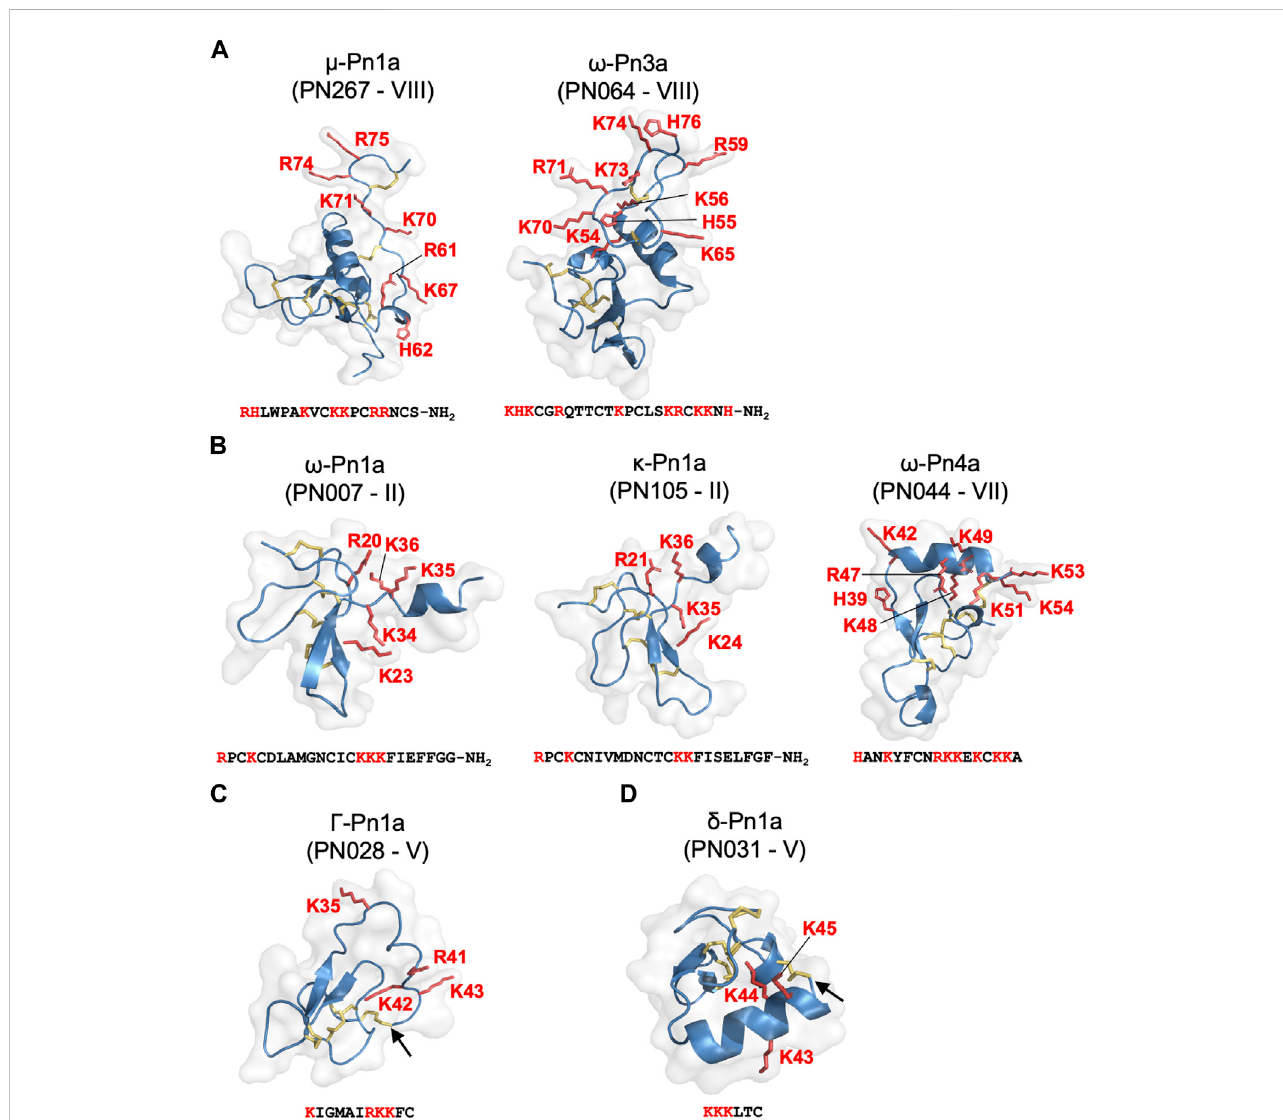
FIGURE 6 Pharmacological groups identi fi ed in the most active venom fractions highlighting the “ KR electrostatic trap ” pharmacophore common to spider toxins that modulatethe activityof ion channels. (A) Group 1 isrepresented by μ -and ω -spider-venom peptides with large and complex type VIII scaffold. (B) Group 2isrepresentedby κ -and ω -spider-venompeptideswithtypeIIandVIIscaffolds. (C) Group3isrepresentedby γ -spider-venompeptideswithtypeVscaffold. (D) Group 4 is represented by δ -spider-venom peptides displaying a type V scaffold. K and R residues located in the C-terminal region of these peptides and grouped on a positively charged face are highlighted in red in the sequences and in red tubes in the corresponding 3D structures. Arrows shows the cysteine-bridge connection forming the cyclic peptide structures predicted for PN028 and